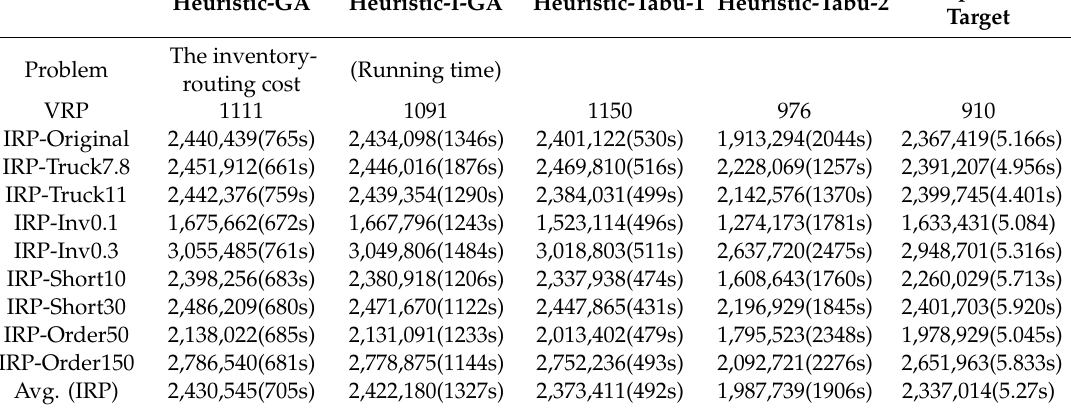
Table 22. The performance comparison regarding the total distance of the VRP simulated case and the inventory-routing cost of nine IRP simulated cases for Heuristic-GA, Heuristic-Immune-GA, Heuristic-Tabu-1, Heuristic-Tabu-2, and the repeated target heuristic method 4 .